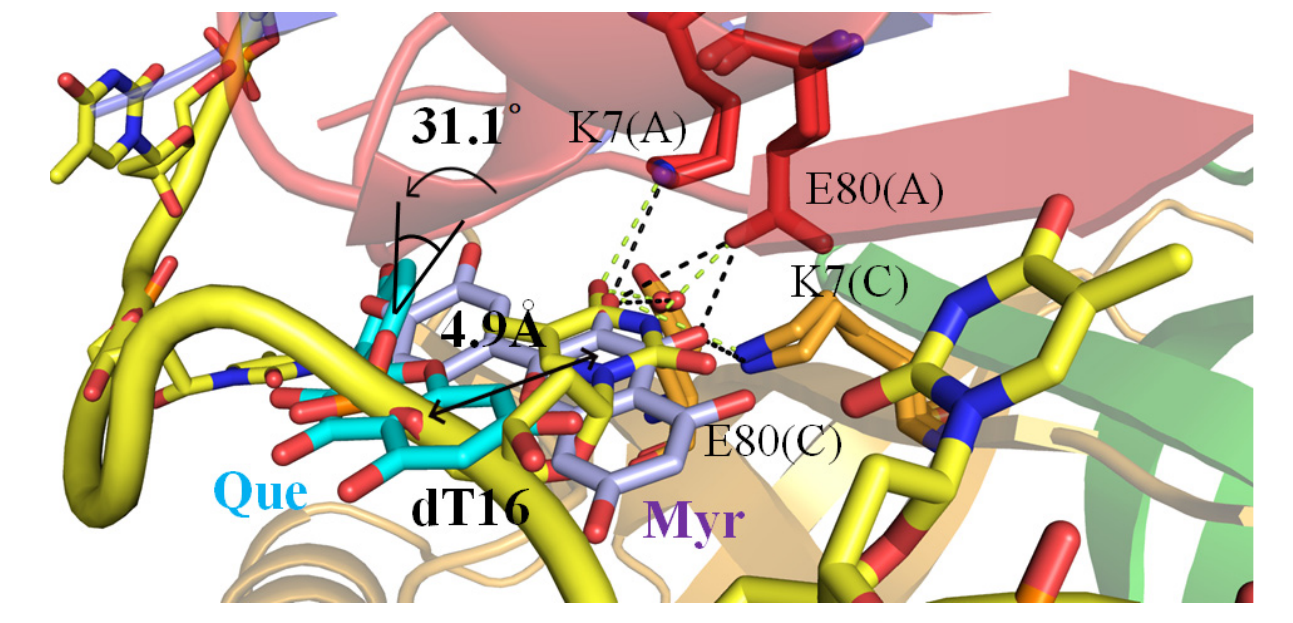
Figure 6. Structural comparison of the PaSSB complex among the quercetin, myricetin, and ssDNA- bound states of PaSSB. Monomers A and C of PaSSB are colored in red and bright orange, respectively. ssDNA is in gold. Quercetin is in cyan. Myricetin is in light blue. Superimposing these com ‐ plexed structures revealed that both Lys7 and Glu80 (monomers A and C), which interacted with myricetin but not quercetin, were also crucial ssDNA binding sites. The side chain position of Lys7 and Glu80 was too distant to interact with quercetin. Compared with myricetin, the aromatic ring of quercetin shifted by a distance of 4.9 Å and an angle of 31 o for hydrogen bonding to the side chain of Asn108 in PaSSB. Myricetin might compete with ssDNA for binding sites Lys7 and Glu80 and/or occupy these binding sites, thus preventing ssDNA from fully wrapping in PaSSB. These differences might be the reason why myricetin could, but quercetin could not, inhibit the ssDNA binding activ ‐ ity of PaSSB.